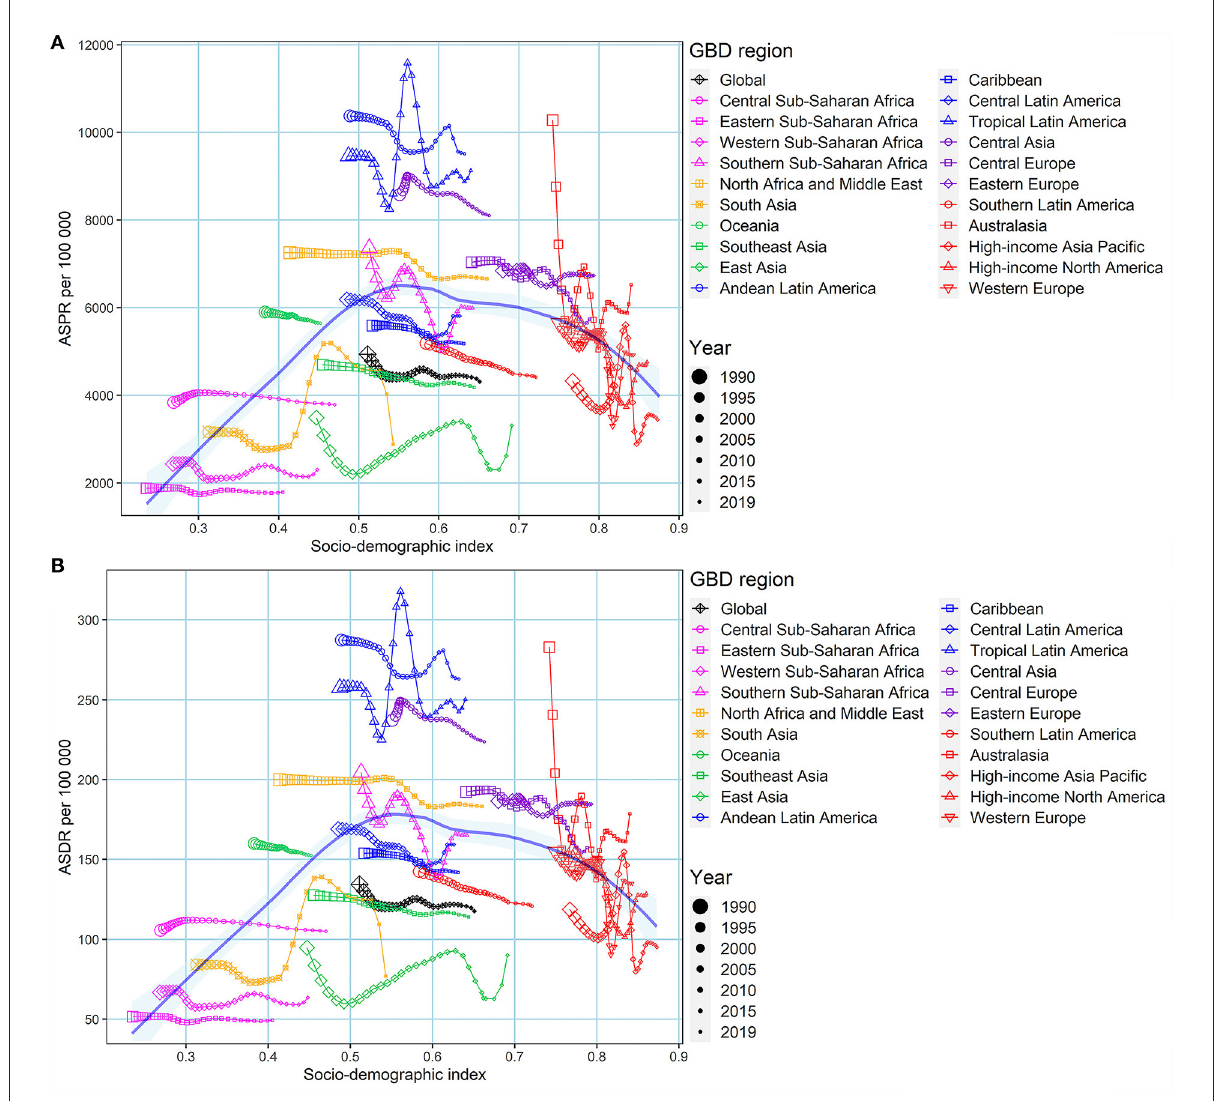
FIGURE5 The association between ASPR, ASDR, and SDI by GBD regions from 1990 to 2019. (A) ASPR; (B) ASDR. The blue line was an adaptive association fitted with adaptive Loess regression based on all data points. GBD, global burden of disease; ASPR, age-standardized prevalence rate; DALYs, disability-adjusted life years; ASDR, age-standardized DALY